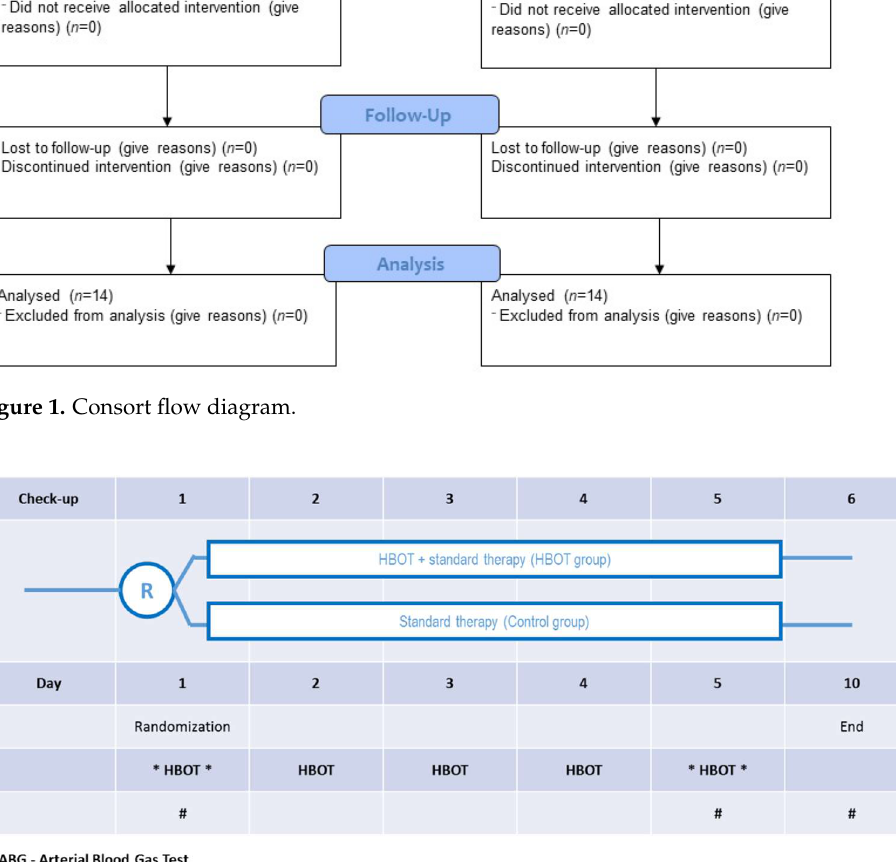
Figure 1. Consort flow diagram.